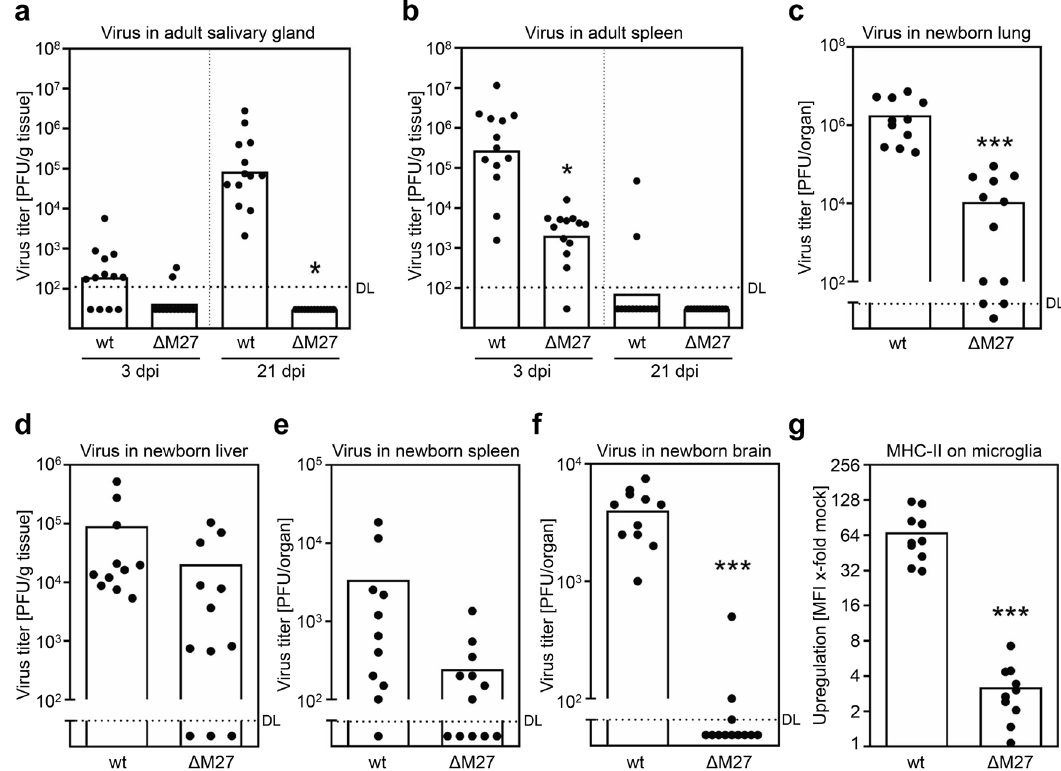
Fig. 1 Δ M27-MCMV replicates to low levels at early times post-infection. BALB/c mice were infected i.p. with wt-MCMV or Δ M27-MCMV. At 3 and 21 days post-infection (dpi), the indicated organs were collected and frozen. The virus titers were determined from organ homogenates by plaque titration. Titrations were performed in quadruplicates. Pooled data of three independent experiments are shown. Bars depict the geometric mean, dots show the titers of individual mice ( n = 13). DL detection limit. a Virus titer in the salivary gland. b Virus titer in spleen. c – f Newborn C57BL/6 mice were i.p. injected with 500 PFU of WT- or Δ M27-MCMV at ~24 h postpartum, and viral titers were determined in indicated organs at 9 dpi by plaque assay. Titers of individual mice (dots) and median values (bars) are shown ( n = 11 – 12). g As in C, but surface expression of MHC-II by live CD45 int CD11b + microglia cells was determined by cytometry. The gating strategy is shown in Supplementary Fig. 1. Median fl uorescence intensity (MFI) values of MHC-II expression were normalized to mock control samples ( n = 10). Signi fi cance was calculated by heteroscedastic unpaired one-tailed t -test. * p < 0.05. *** p <